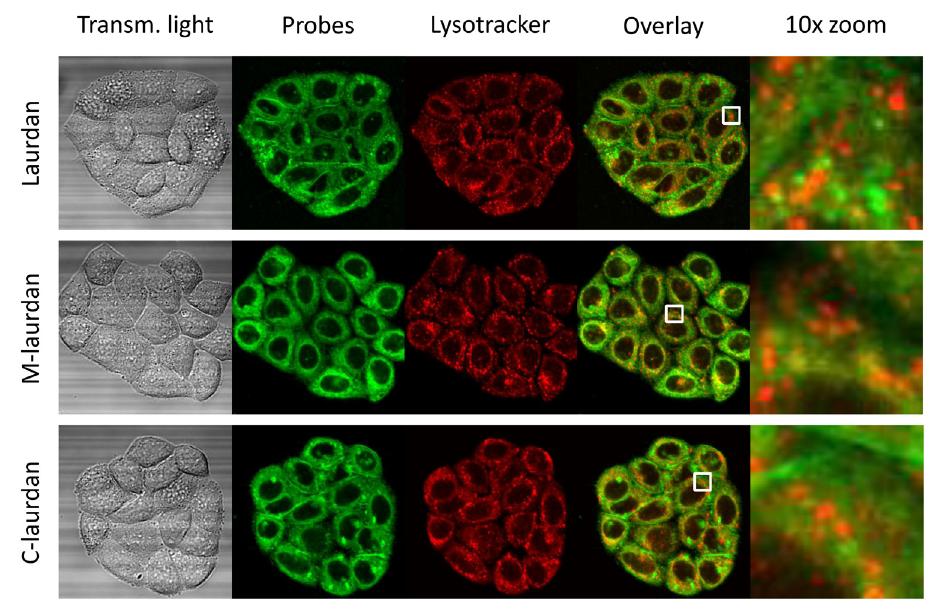
Figure 2. The intra-cellular vesicles labelled by Laurdan, and to a lesser extent by M-laurdan, do not co-localize with lysotracker. Hela cells were grown on glass coverslips for four days before double-labelling with lysotracker red and either Laurdan (first line), M-laurdan (second line) or C-laurdan (third line), as described in M&M. The live cells, kept at 37°C, were then imaged over 30 channels: 29 fluorescence channels spanning from 420 to 700 nm, plus transmitted light (First column). The stacks were then used to perform spectral deconvolution with the poisson NMF pluggin, using the spectra acquired with cells labelled with only one probe as references. The second column shows the signals allocated to the Laurdan-family probes, artificially coloured in green. The third column shows the signals allocated to lysotracker red, artificially coloured in red. The fourth column shows an overlay of the two signals, and the fifth column shows 10× zoom corresponding to the white squares in the fourth column. Width of the squares: 10 µm.